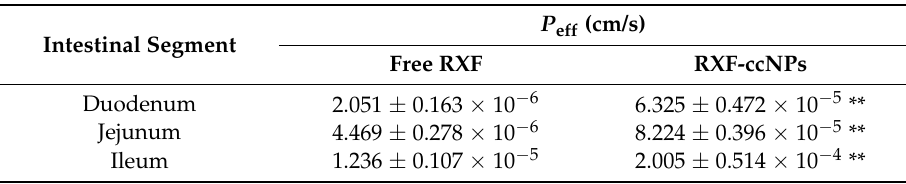
Table 2. The effective intestinal permeability ( P eff ) of free RXF and RXF-ccNPs determined by in situ single-pass intestinal perfusion ( n =